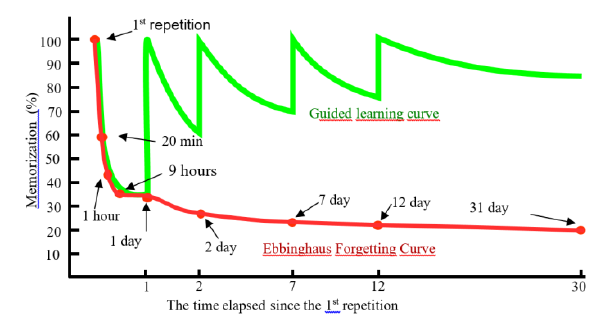
Fig. 4 . Comparison of Guided and Unguided Learning Processes.